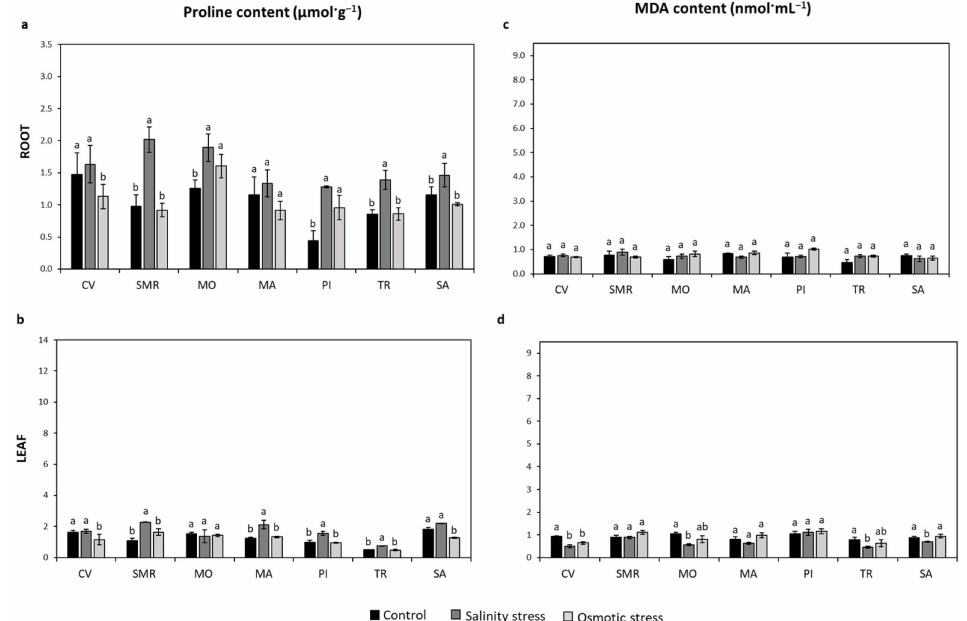
Figure 5. Proline and MDA content. The proline ( µ mol · g − 1 ; panel a and b ) and malondialdehyde (MDA, nmol · mL − 1 ; panel c and d ) contents were measured in the root and leaf of seven common bean populations grown under controlled, salt-, and osmotic-stress conditions. Data represent the mean ( n = 4) ± standard error. A Student’s t -test was conducted to weigh the effects of different treatments ( p ≤ 0.05). Mean values marked with the same letter are not statistically different.